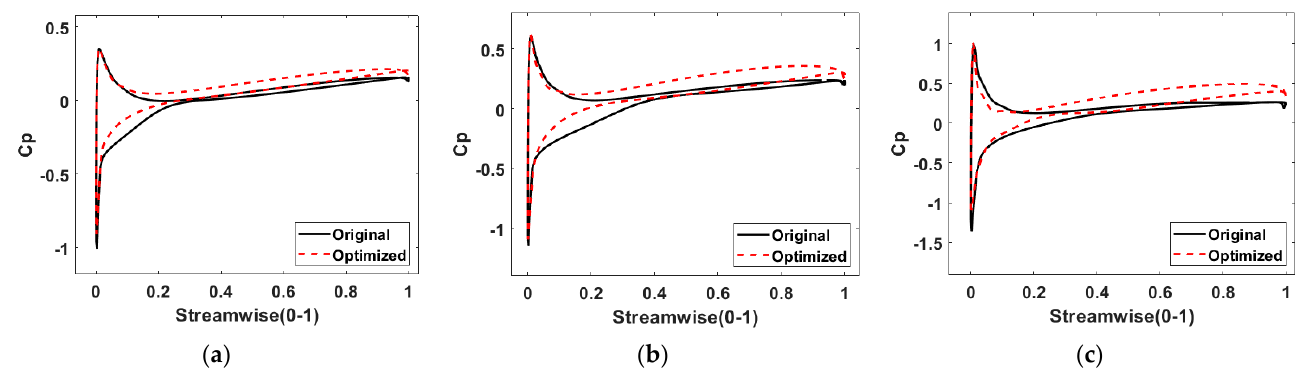
Figure 10. Axial distribution of static pressure coefficient: ( a ), ( b ) and ( c ) are the 20%, 50% and 80% span layers of the blade, respectively.